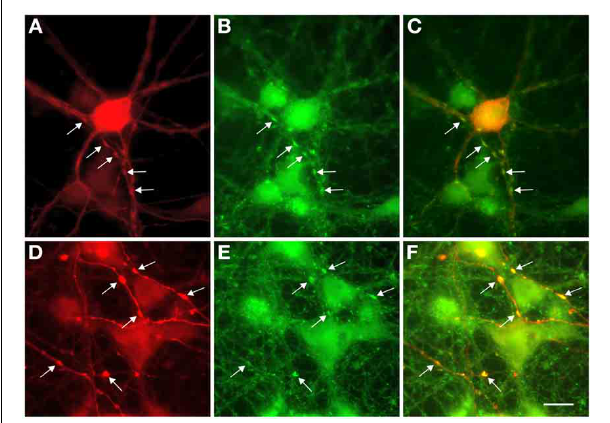
FIGURE 5 | Colocalization of GABA and synaptophysin immunostainings in 13-day-old cultures. (A,D) GABA staining shows prominent swellings along the axons of L-GABA neurons (arrows). (B,E) . These boutons contain the synaptic protein synaptophysin. (C,F) . Double exposure of (A,B) and ( D,E) shows GABA/synaptophysin colocalization. Scale bar = 10 μ